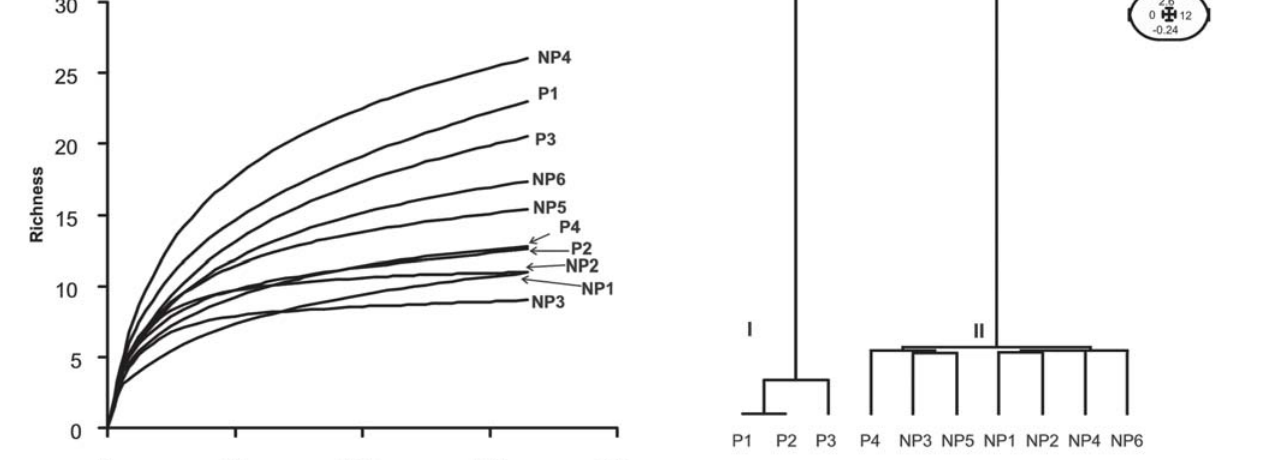
Fig. 3. Fish assemblage dendogram resulting from the Morisita-Horns analysis. Roman numerals indicate the groups and the small box the scale of variance. P1 = Macaúba; P2 = Carapina; P3 = Barreiro; P4 = Cana Brava; NP1 = Palmito; NP2 = Onça; NP3 = Unnamed Stream 3; NP4 = Bandeira; NP5 = Pedreira; NP6 = Unnamed Stream